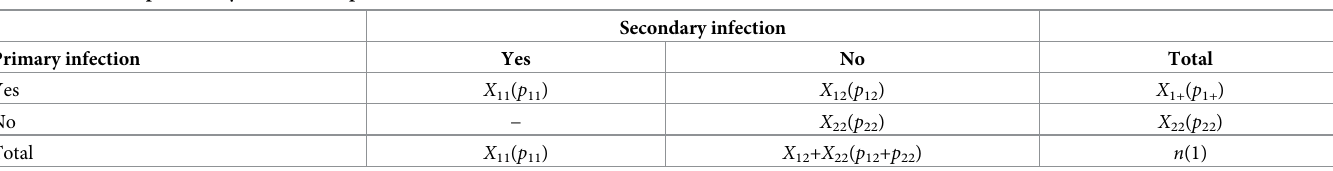
Table 1. Data and probability for an incomplete 2 × 2